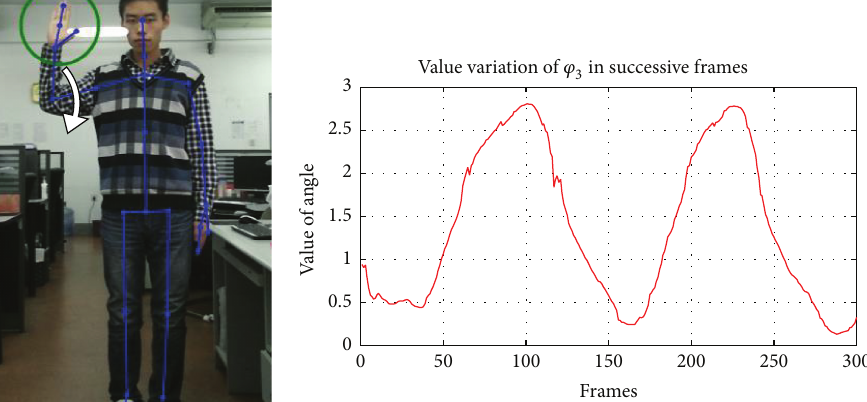
Figure 6: The operator keeps his body still and only rotates his arm circularly, constantly, and with a low and smooth speed from the origin position to limiting position.